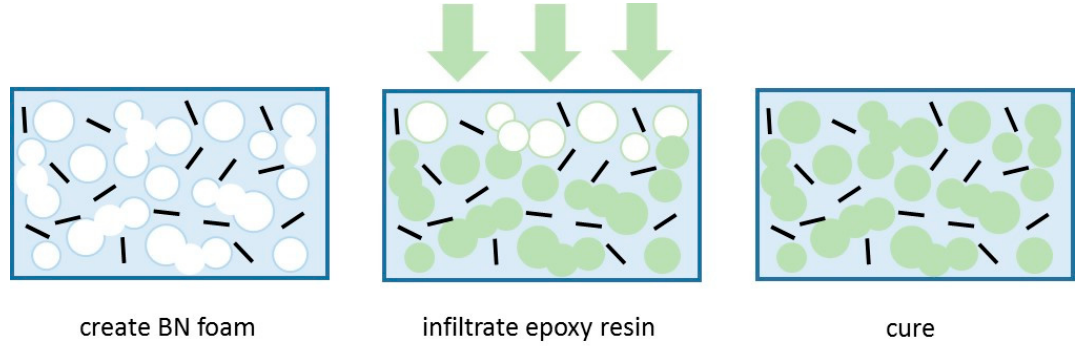
Figure 12. Schematic illustration of the fabrication of porous BN foam and epoxy-BN composite.